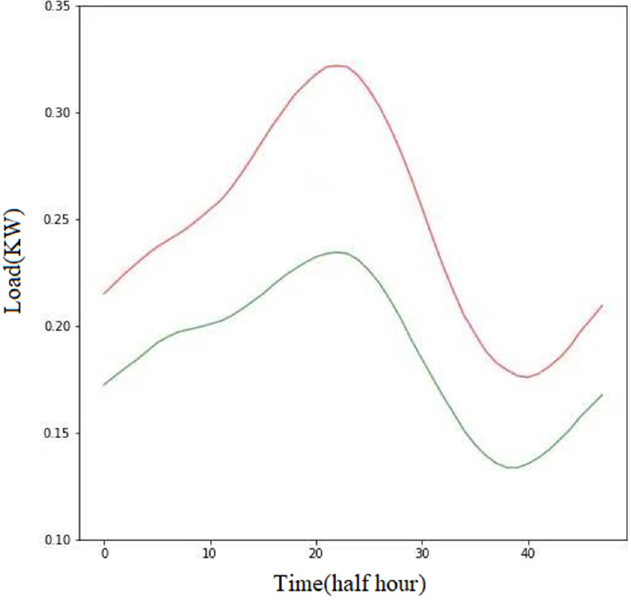
Figure 6. Daily average electricity consumption of two types of residents after clustering.